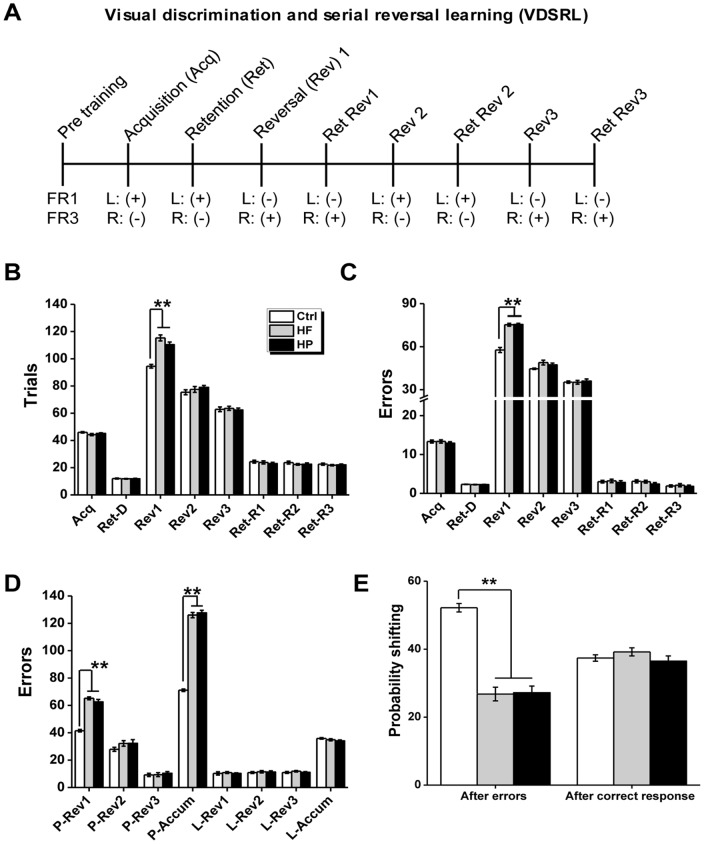
Reversal learning in the VDSRL task.(A) Schematic representation of the behavioral training and testing protocol. The rewarded and unrewarded lever is indicated by the “+” and “−”, respectively. The rewarded lever was counterbalanced across rats. (B–C) Total trials (B) and errors (C) to criterion during acquisition of spatial discrimination (Acq), retention of discrimination (Ret-D) as well as during the reversal phases (reversal 1–3: Rev1–3; retention of reversal 1–3: Ret-R1-3). (D) Perseverative and learning errors accumulated across reversals (perseverative errors accumulated: P-Accum;learning errors accumulated:L-Acuum) and during 3 reversals (perseverative errors of reversal 1–3: P-Ret1-3; learning errors of reversal 1–3: L-Ret1-3) were shown. A series of three reversals were performed by male offspring born to dams fed with the Ctrl diet, HF diet, and HP diet. Between successive reversals, animals were given a session to test retention of the previous reversal phase (Ret-R1-3). (E) Mean probabilities of rats shifting their responding to the other stimulus after making either an incorrect choice (and therefore not receiving reward) or a correct choice and receiving reward. n = 9 for Ctrl group, n = 10 for HF group and n = 11 for HP group. *p<0.05; **p<0.001.